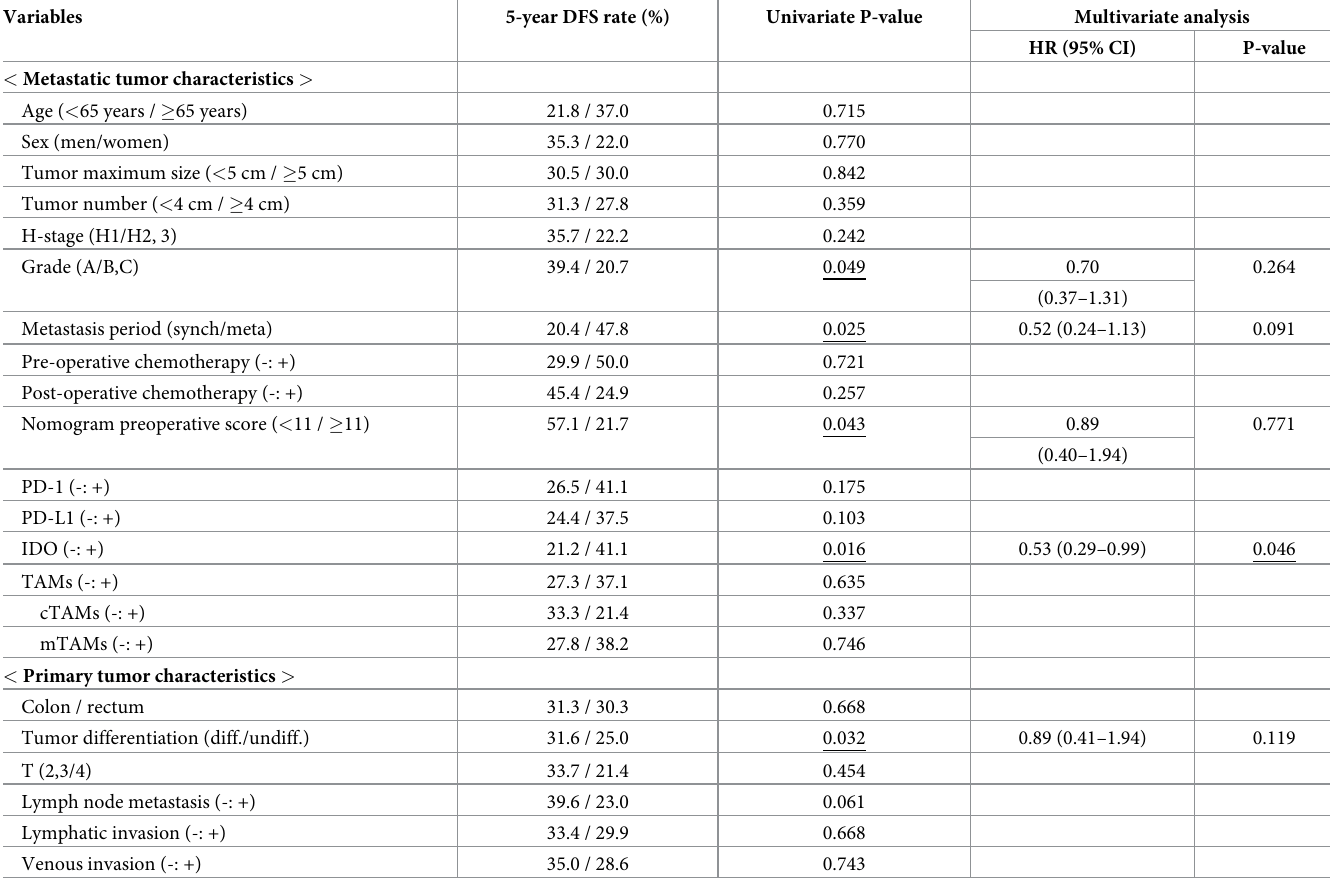
Table 6. Univariate and multivariate analysis of clinicopathological factors associated with disease-free survival after